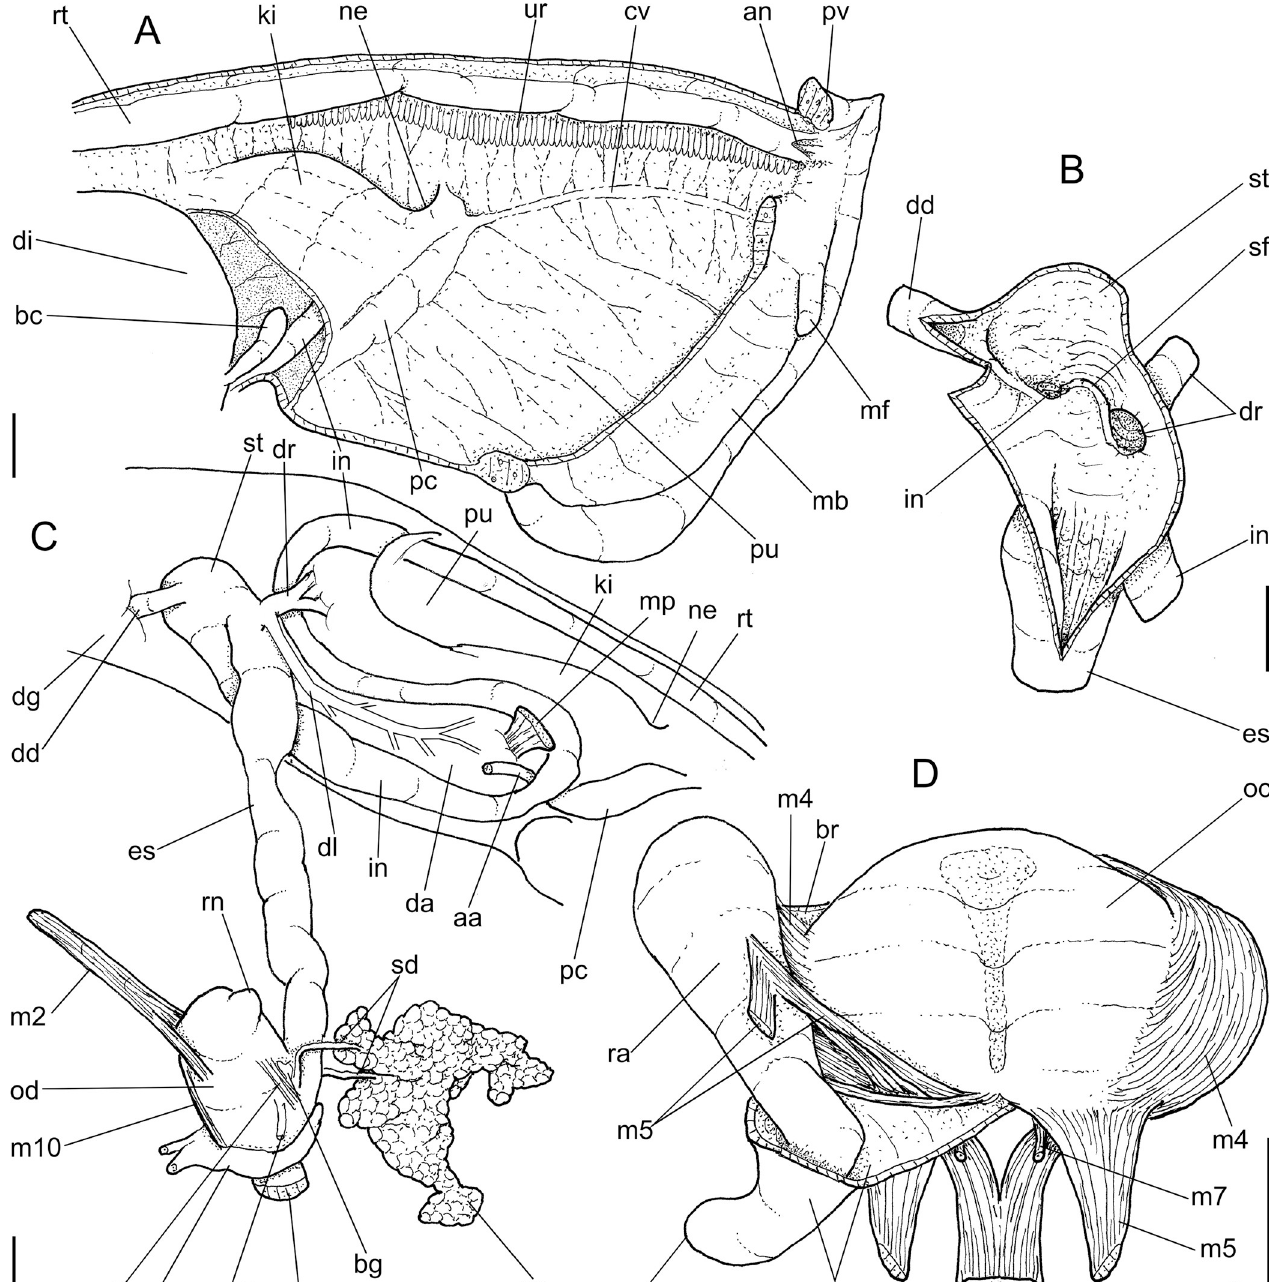
Fig 6. Anthinus synchondrus , anatomy. (A) pallial cavity roof, ventral view, pneumostome ventral lip sectioned and deflected upwards, portion of pallial floor also shown. (B) stomach opened longitudinally, ventral view. (C) digestive tubes mostly as in situ, ventral view, topology of some adjacent structures also shown. (D), odontophore, dorsal view, superficial layer of muscles and structures removed, left muscles deflected, radula deflected to left. Scales = 2 mm. Anus directly opening externally (ventrally), preceded by right longitudinal folds (Fig 5N: af). Urinary gutter (ur) slightly broader, with slightly taller perpendicular folds. Visceral mass. Similar features as preceding species.